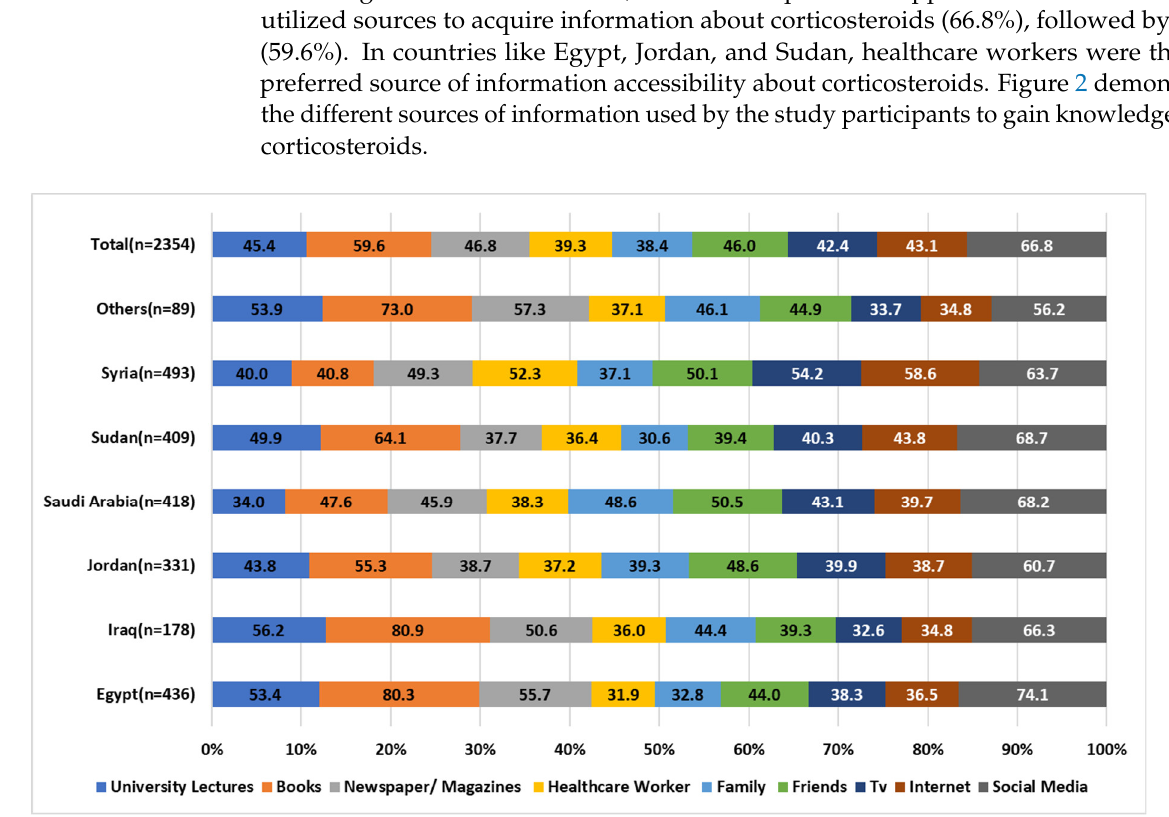
Figure 2. Sources of information about corticosteroids. Participants were able to choose more than one option.